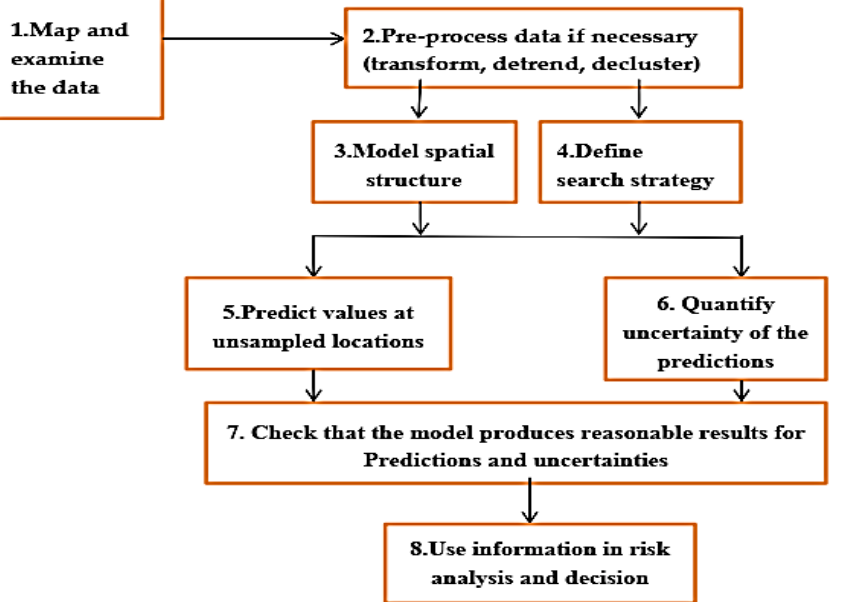
Figure 3. Flow chart in the process of conducting geo-statistics.